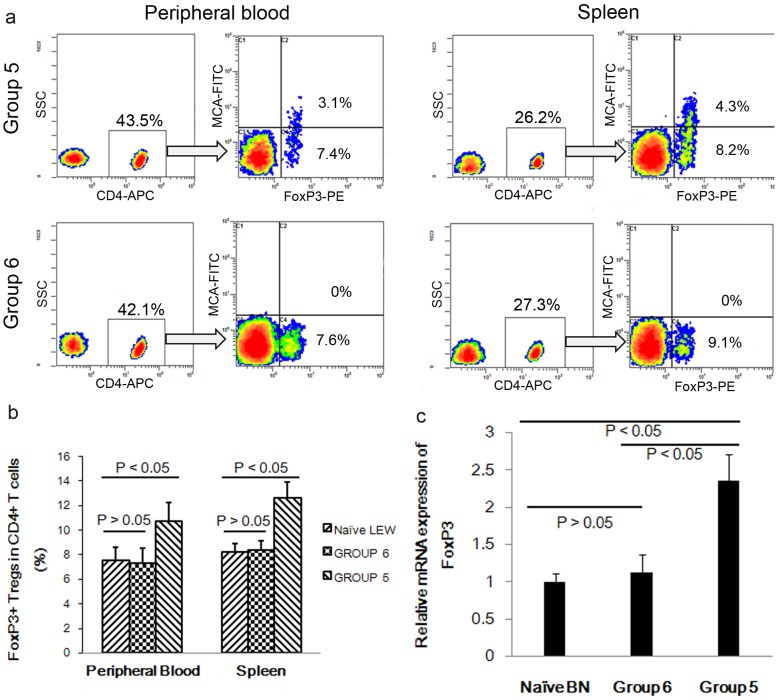
Location of FoxP3+ Tregs in rats receiving CsA treatment.(a) Representative dot plots of donor-specific FoxP3+ Tregs in peripheral blood and spleen from allograft recipients in groups 5 and 6 at the end of the observation period. Mononuclear cells were obtained by Ficoll solution centrifugation, followed by magnetic isolation of CD4+ T cells. Isolated CD4+ T cells were then co-stained with anti-rat mAb RT1n-FITC and intracellularly stained with anti-mouse/rat Foxp3-PE. All cells were analyzed by flow cytometry. The results demonstrated that donor-specific FoxP3+ Tregs were exclusively obtained in both the peripheral blood and spleens of long-term allograft recipients in group 5. (b) Further analysis indicated an average proportion of 10.7%±1.1% versus 7.6%±1.6% and 12.6%±0.7% versus 8.3%±1.1 FoxP3+ Tregs located in the peripheral blood and spleen in group 5 and 6, respectively, with significant differences (n = 6, P<0.05). (c) Expression of FoxP3 mRNA in the allografts was analyzed by real-time PCR normalized to GAPDH. Significantly higher levels of FoxP3 were observed in group 5 (n = 6, P<0.05).